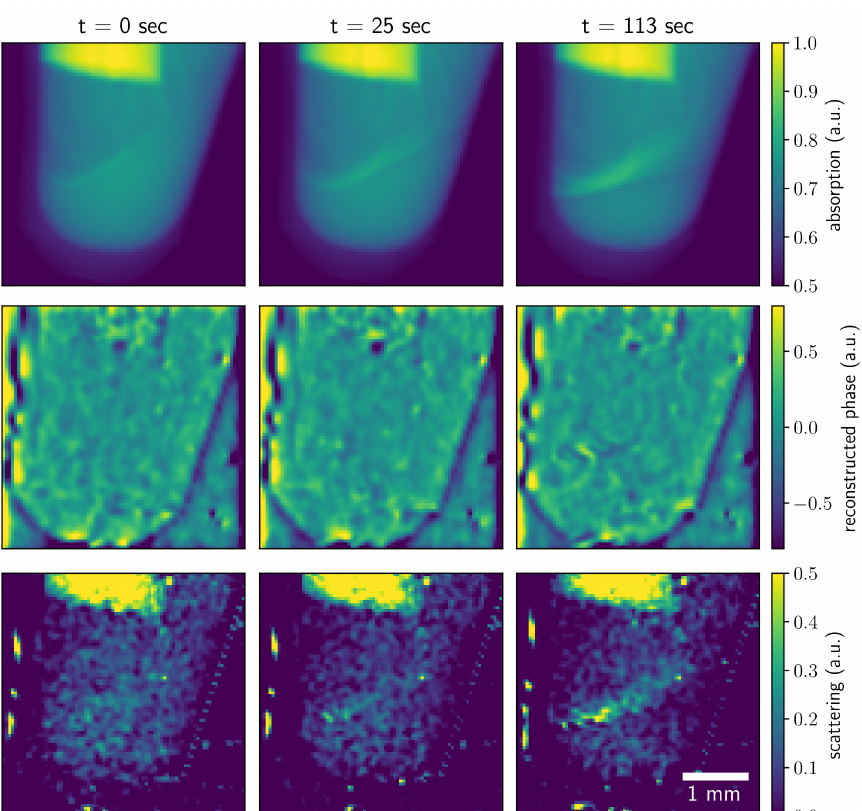
Figure 6. Absorption, reconstructed phase, and average scattering contrasts recorded at different measurement times (0, 25, and 113 s) illustrate the evolution of the chemical reaction.